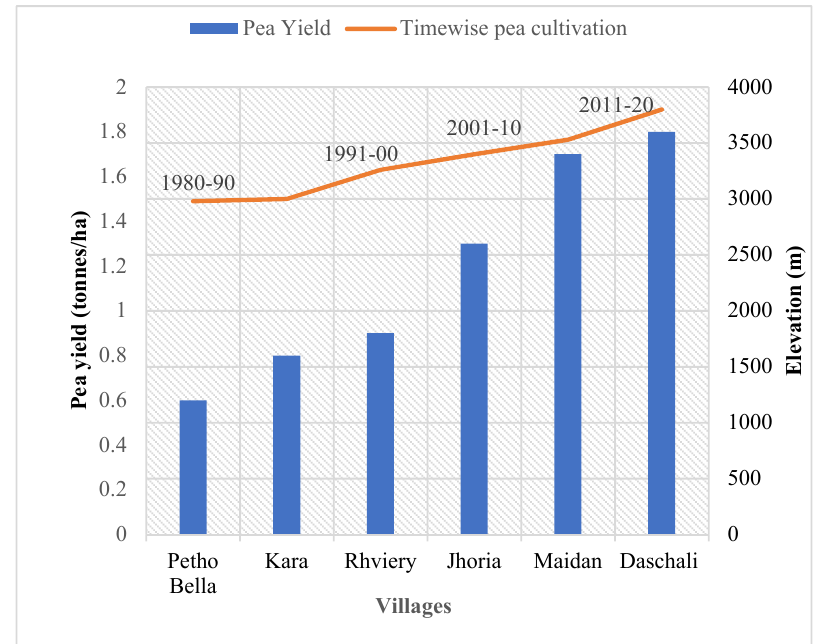
Figure 2. Time- and elevation-wise pea productivity in Buhrawai valley.